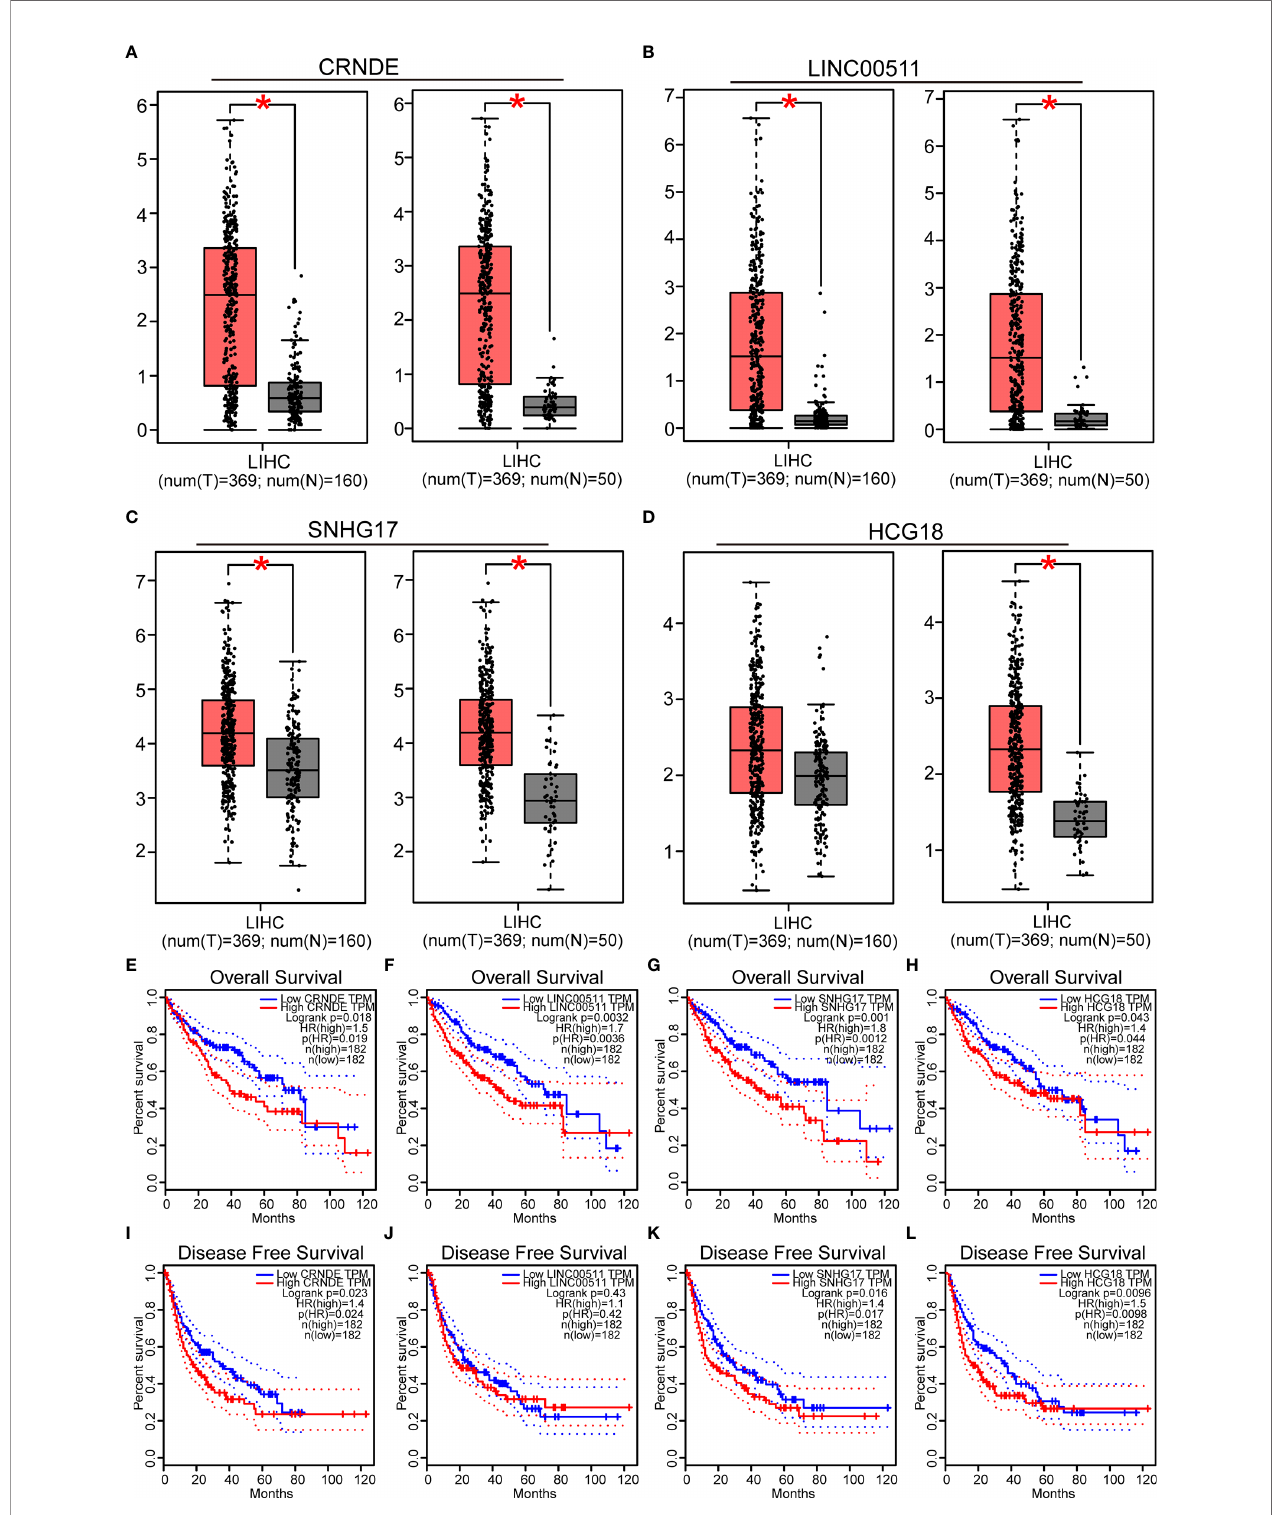
FIGURE 5 | Prediction and analysis of lncRNAs upstream of miR-29c-3p. (A – D) Expression of CRNDE (A) , LINC00511 (B) , SNHG17 (C) and HCG18 (D) in LIHC data compared with that in “ TCGA normal ” or “ TCGA and GTEx normal ” data. (E – L) OS analysis of CRNDE (E) , LINC00511 (F) , SNHG17 (G) and HCG18 (H) in LIHC. RFS analysis of CRNDE (I) , LINC00511 (J) , SNHG17 (K) and HCG18 (L) in LIHC. ∗ p value <